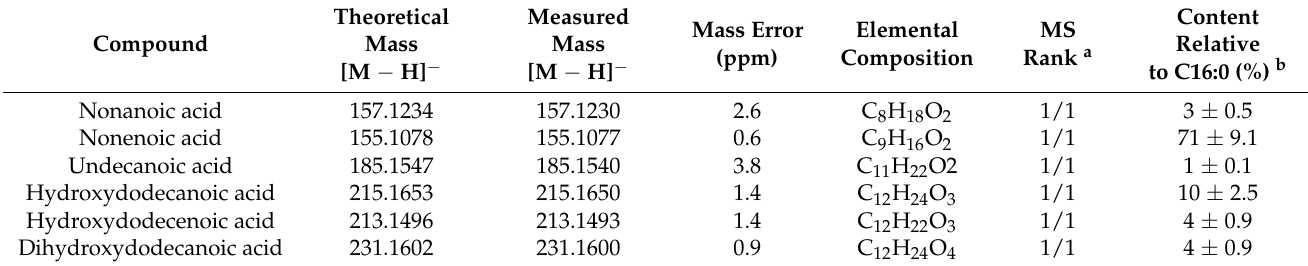
Table 2. Contents of suspect FFAs in RJ samples relative to palmitic acid.